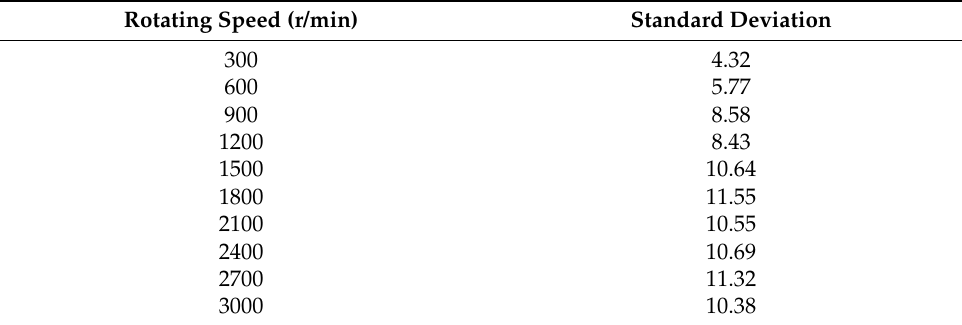
Table 4. Rotation speed–pressure–standard deviation